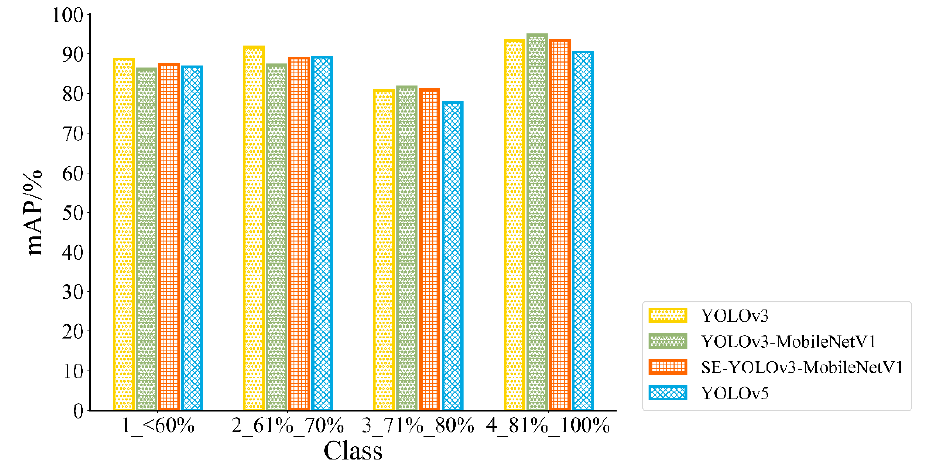
Figure 9. Test results of four different models on four different maturity levels .